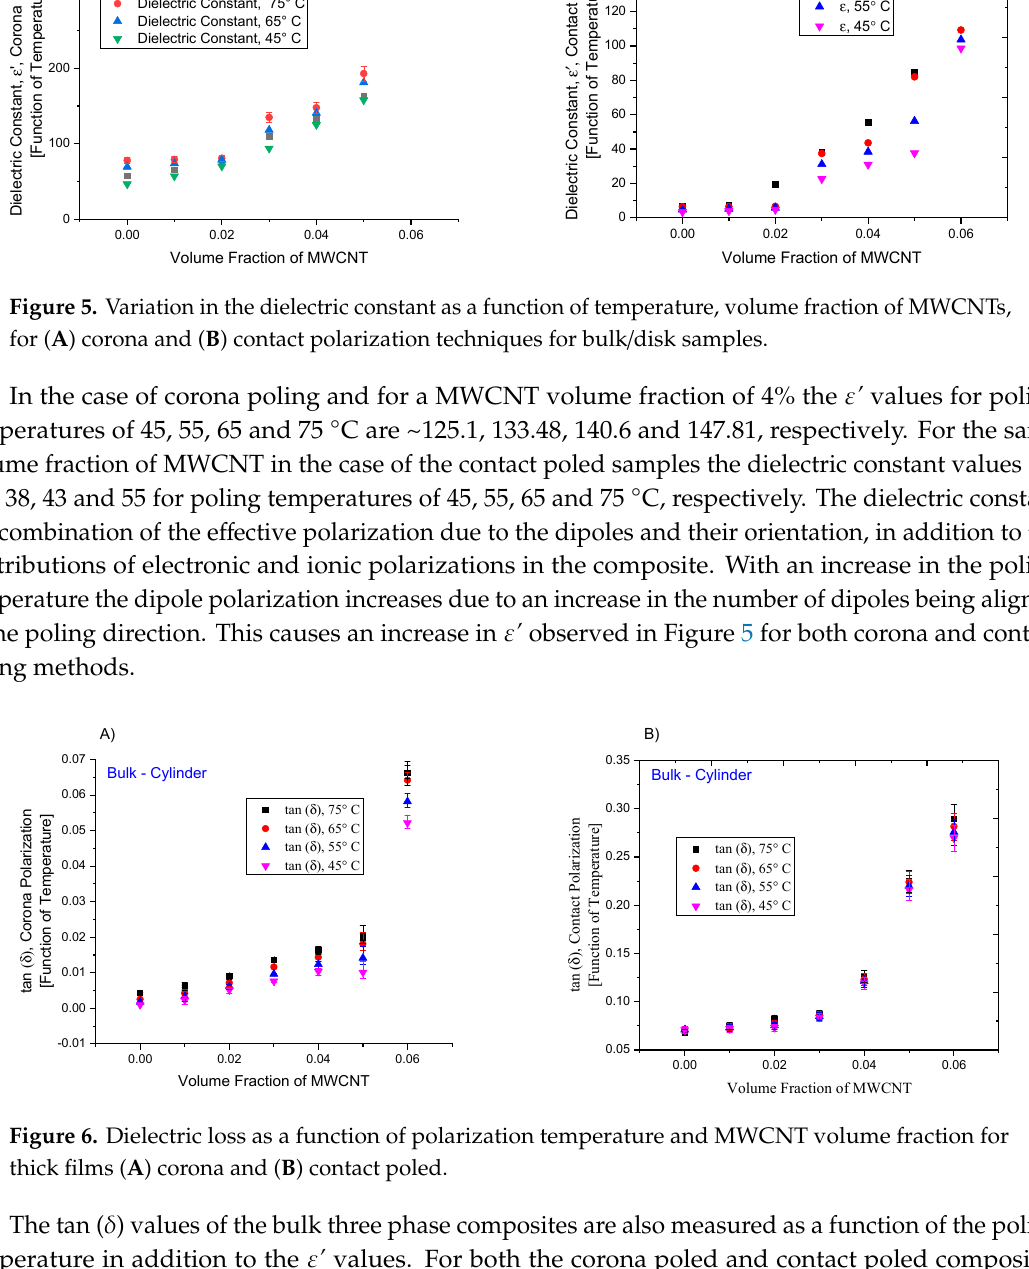
Figure 6. Dielectric loss as a function of polarization temperature and MWCNT volume fraction for thick films ( A ) corona and ( B ) contact poled.